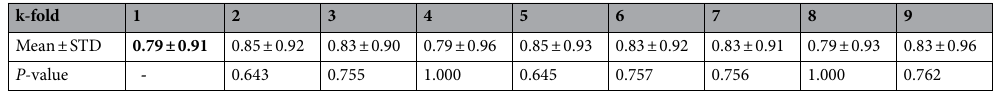
Table 3. Comparisons of distance error (mean ± STD, unit: mm) using ninefold cross validation. ninefold cross-validation results. The accuracy of w/ ROI detection (segmentation/variable size) was compared with the other accuracies with independent t-test. STD standard deviation.